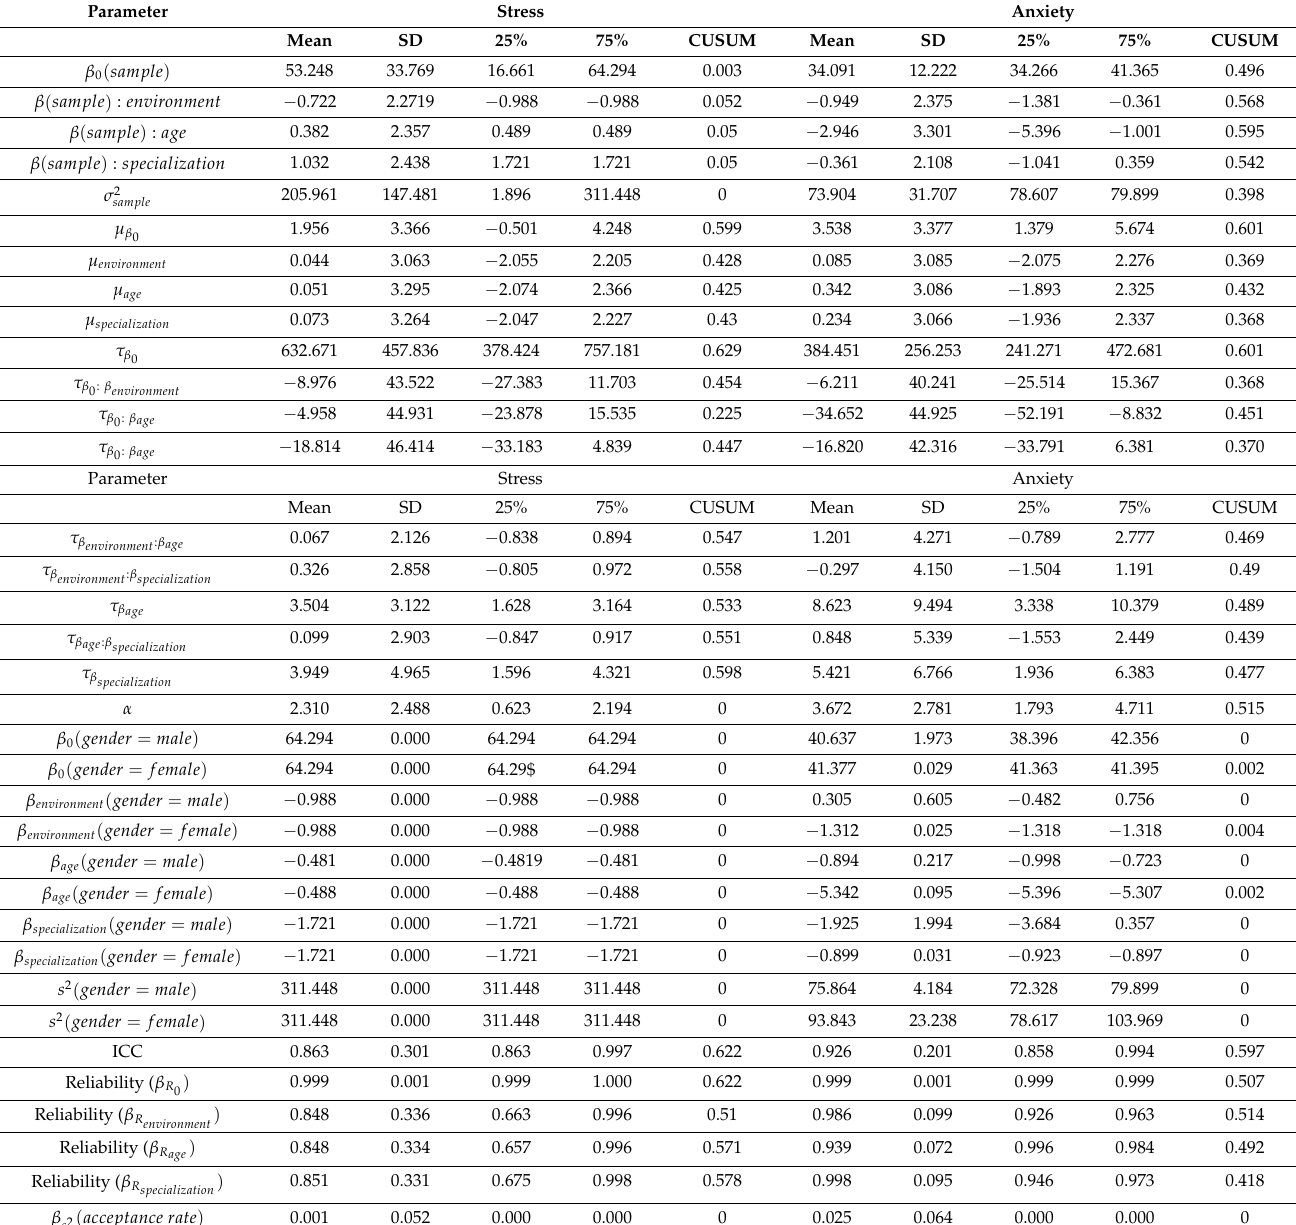
Table 3. Posterior Summary Estimates for explaining students’ stress and anxiety scores according to